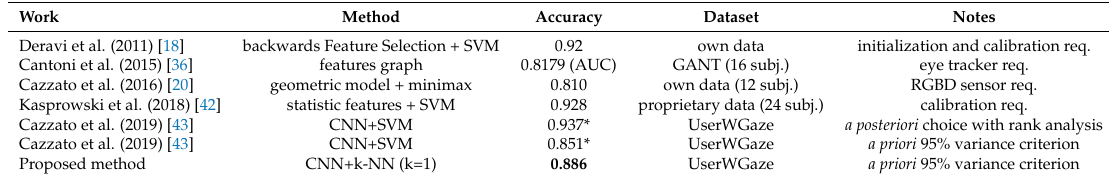
Figure 14. Top-N Accuracy varying the number of classes for different values of k of the k-NN clasifier. Table 2. Comparison with related approaches in the state of the art. AUC stands for Area Under Curve, subj. for subjects., req. for required. Results marked with * have been reproduced on the UserWGaze